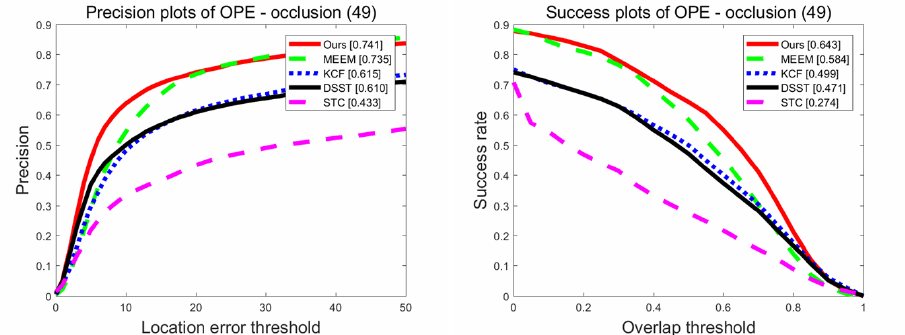
Figure 5. Precision and success plots of OPE during occlusion. The legend contains the AUC score for each tracker.